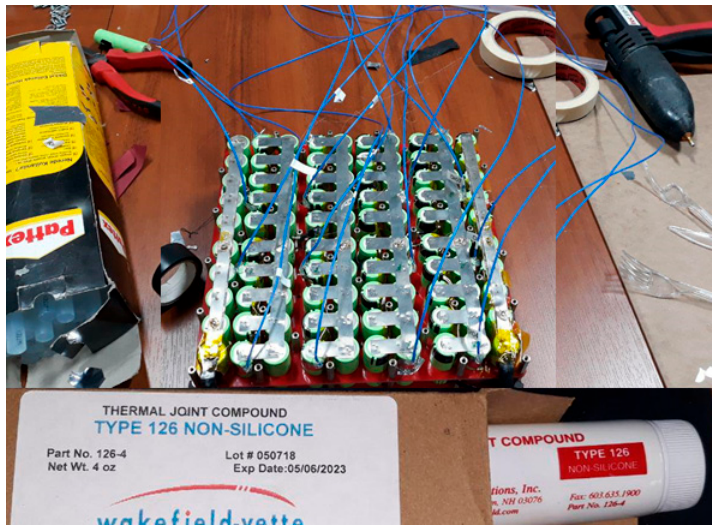
Figure 9. Sensor attachment measures.